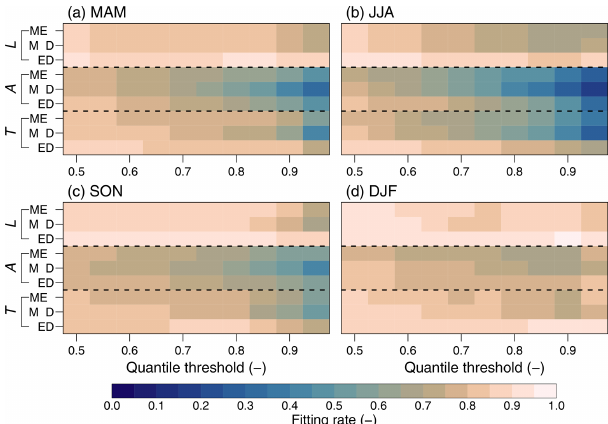
Figure 1. Fitting rates of different paired comparisons as a func- tion of quantile threshold by using global data (see Sect. 2.3). The subplots represent different seasons. The three bands (separated by dashed lines) in each subplot indicate the land leg ( L ), the atmo- spheric leg ( A ), and the total ( T ). Within each band, the three rows represent three paired comparisons; they are (from top to bottom) M vs. E, M vs. D, and E vs.